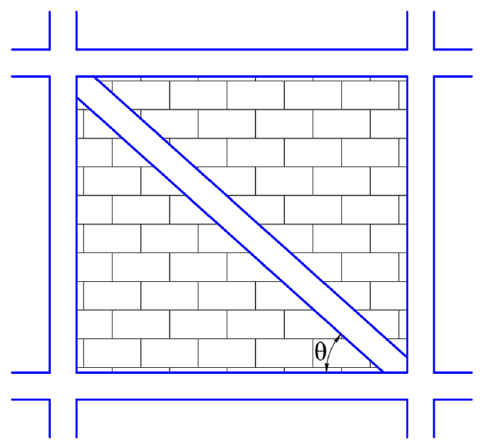
Figure 4. Infill masonry model for double wythe brick walls.